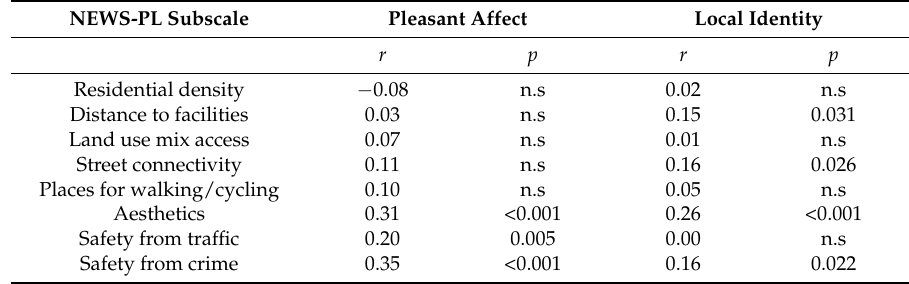
Table 2. Correlation matrix between NEWS-PL subscales, pleasant affect and local identity (N = 196).